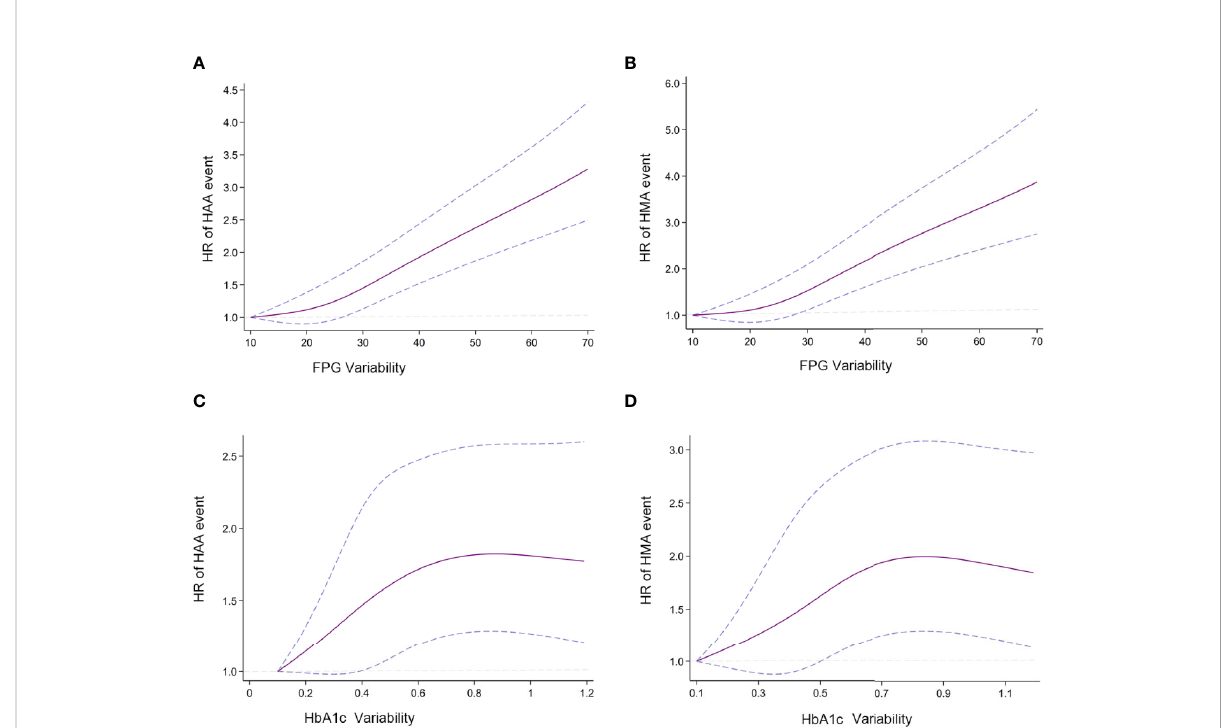
FIGURE 2 Association of predicted HAA/HMA event and HbA1c/FPG variability (A) Association of FPG variability and HAA event; (B) Association of FPG variability and HMA event; (C) Association of HbA1c variability and HAA events; (D) Association of HbA1c variability and HMA event. Hazard ratios are indicated by solid lines and 95% CIs by areas between two dotted lines. (Reference point is the lowest value for each curve) The Reference knots were placed at the 5th, 35th, 65th, 95th, centiles of HbA1c/FPG variability distribution. HbA1c/FPG variability were adjusted using model 2.